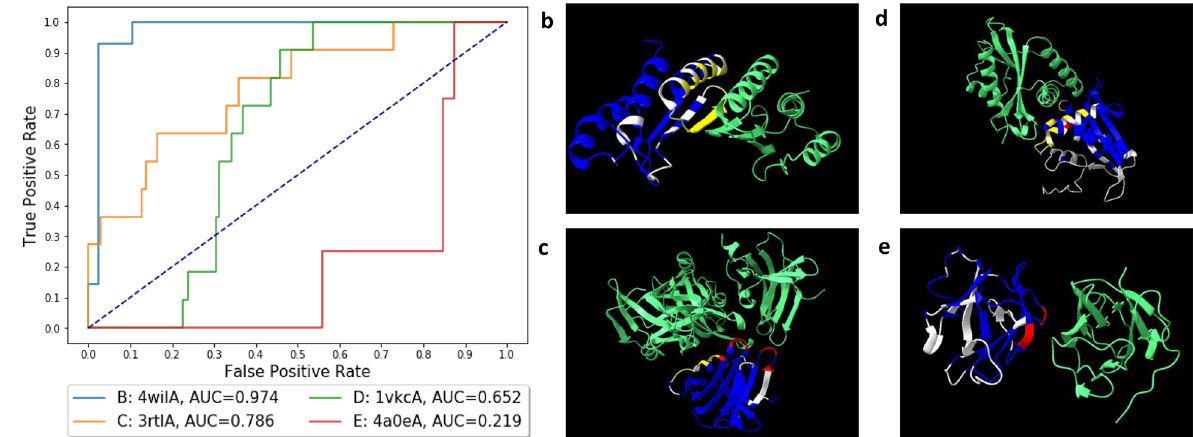
Figure 5. Analysis of four proteins in the test set after training the multi-task model IFBUS3SA on the PPI_extendedSFD dataset. ( a ) The receiver operator characteristics (ROC) curve of the four proteins (4wilA in blue, 3rtlA in orange, 1vkcA in green, and 4a0eA in red) with their corresponding area under the curve score (AUC ROC). ( b – e ) Visualised protein structures corresponding to the proteins in the ROC curve. The protein chains that contain the predicted interface are indicated in dark blue, the binding partners are indicated in green. Correctly predicted residues are colored yellow, false positive residues white and false negative residues red. ( b ) Protein structure of the protein 4wilA, corresponding to light blue line in the ROC curve. ( c ) Protein structure of the protein 3rtlA, corresponding to the orange line in the ROC curve. ( d ) Protein structure of the protein 1vkcA, corresponding to the green line in the ROC curve. ( e ) Protein structure of the protein 4a0eA, corresponding to the red line in the ROC curve.